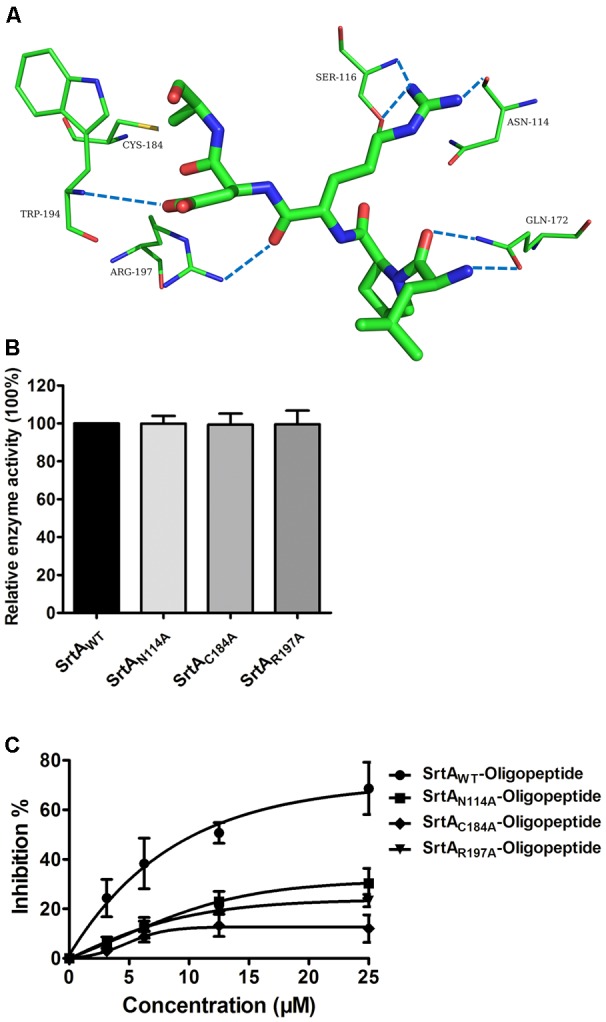
Determination of the binding sites for the oligopeptide on SrtA and its inhibitory mechanism. (A) The predicted binding mode of SrtA with the oligopeptide is shown, with labeling of key residues in the binding sites. (B) The catalytic activity of SrtA and its derivative. The activity of SrtA mutants was calculated by comparison with the wild type SrtA activity that was set to 100%. (C) Influences of the oligopeptide on the activities of SrtA and its derivatives. SrtA was incubated with various concentrations of the oligopeptide, and the fluorescent peptide substrate Dabcyl-QALPTTGEE-Edans was added for determination of SrtA protein activity, as described in Figure 1B (n = 3). Results are reported as mean ± SEM.